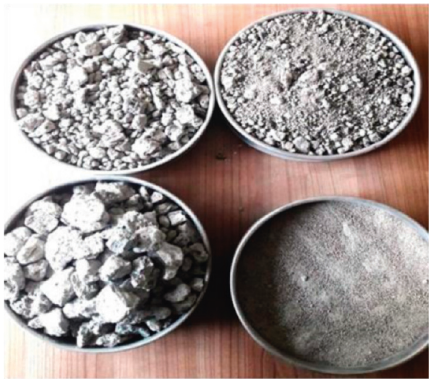
Figure 1: Limestone aggregates used for RWC